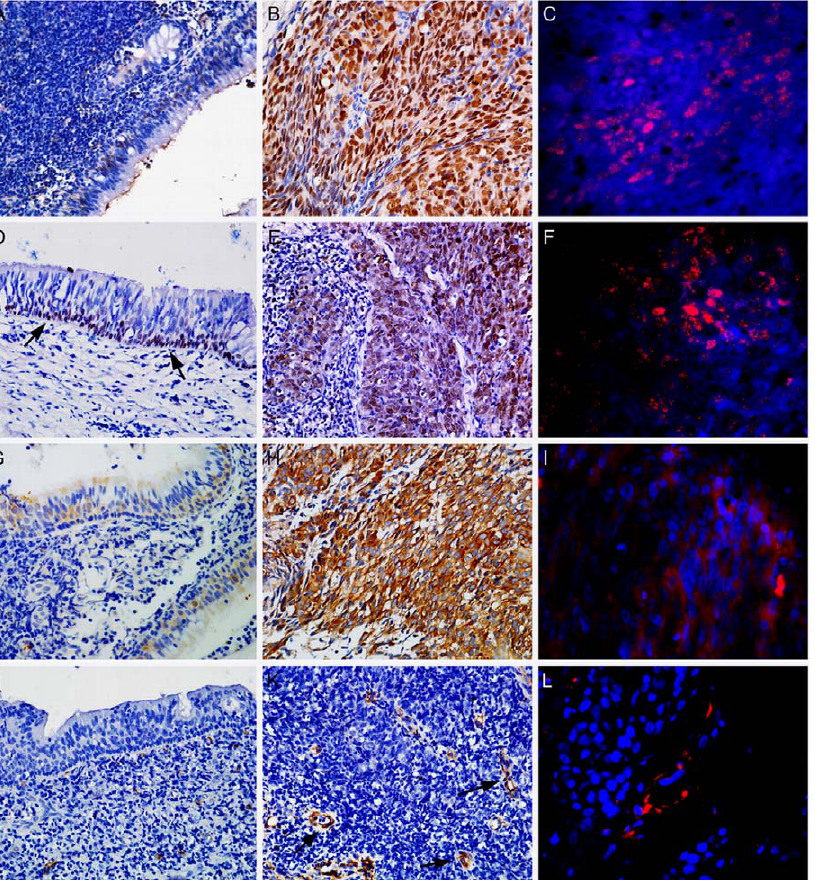
Figure 1. Immunohistochemical staining of embryonic stem cells (ESCs) proteins SOX2, OCT4, Nanog and Nestin in non-cancerous nasopharyngeal tissues and nasopharyngeal carcinoma (NPC). Nuclear SOX2 expression was low in non-tumoral epithelium (A), whereas it was highly expressed in NPC tissues (B). Nuclear staining of OCT4 was limited to basal cells of non-tumoral epithelium (D; arrows indicated) and markedly expressed in tumor cells (E). Low cytoplasmic expression of Nanog was observed in non-tumoral epithelium (G) and strongly displayed in tumor tissues (H). Nestin expression was completely absent in non-cancerous epithelium (J) and tumor cells (K), whereas it was strongly stained in the cytoplasm of endothelial cells in cancer tissues (K; arrows indicated). Immunofluorescent labeling of both SOX2 (C) and OCT4 (C) showed nuclear staining (red), Nanog (I) and Nestin (L) showed cytoplasmic localization (red) of tumor cells and endothelial cells, respectively, DAPI (blue).All images, 6